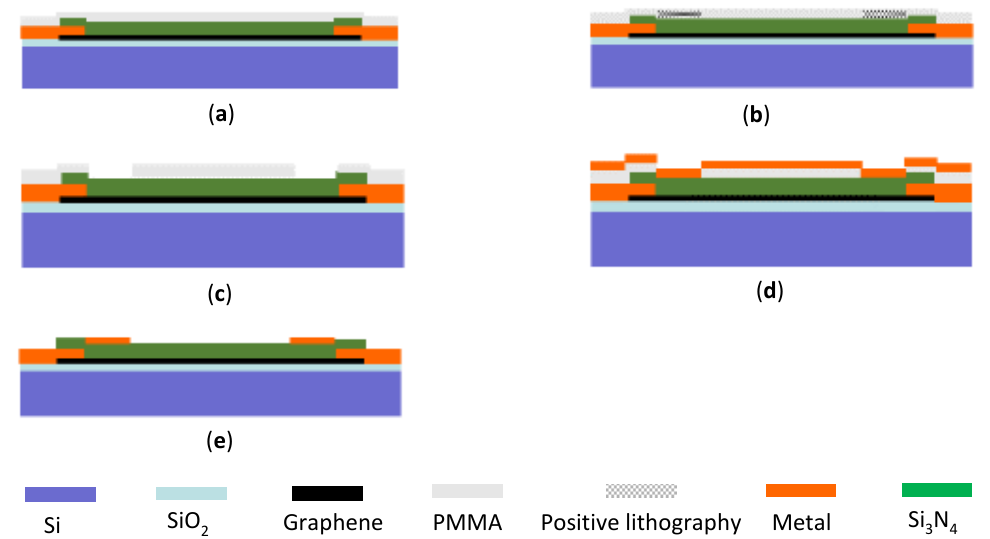
Figure 10. The process flow of the gate electrode. ( a ) Spin-coating positive photoresist ( b ) Electron-beam lithography ( c ) Positive photoresist development ( d ) Evaporating metal ( e ) Stripping.